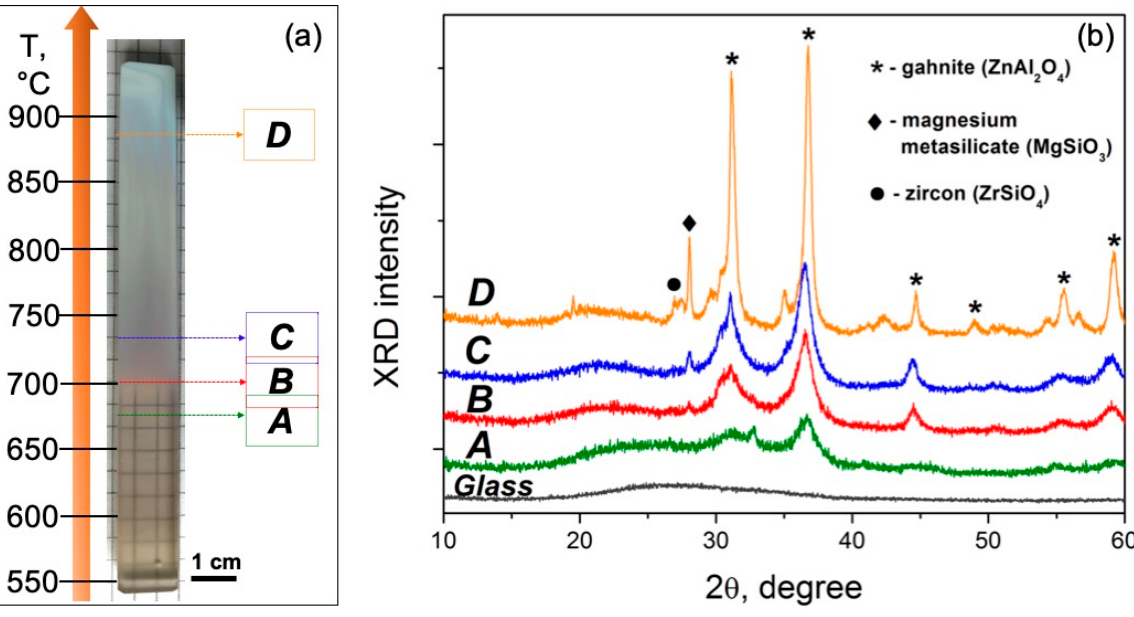
Figure 2. ( a ) Image of the glass sample after the polythermal crystallization. Designations A–D in- dicated in the fi gure denote the zones of further analysis. ( b ) XRD pa tt erns recorded from the cor- indicated in the figure denote the zones of further analysis. ( b ) XRD patterns recorded from the responding zones A–D of the treated sample and initial glass. corresponding zones A–D of the treated sample and initial